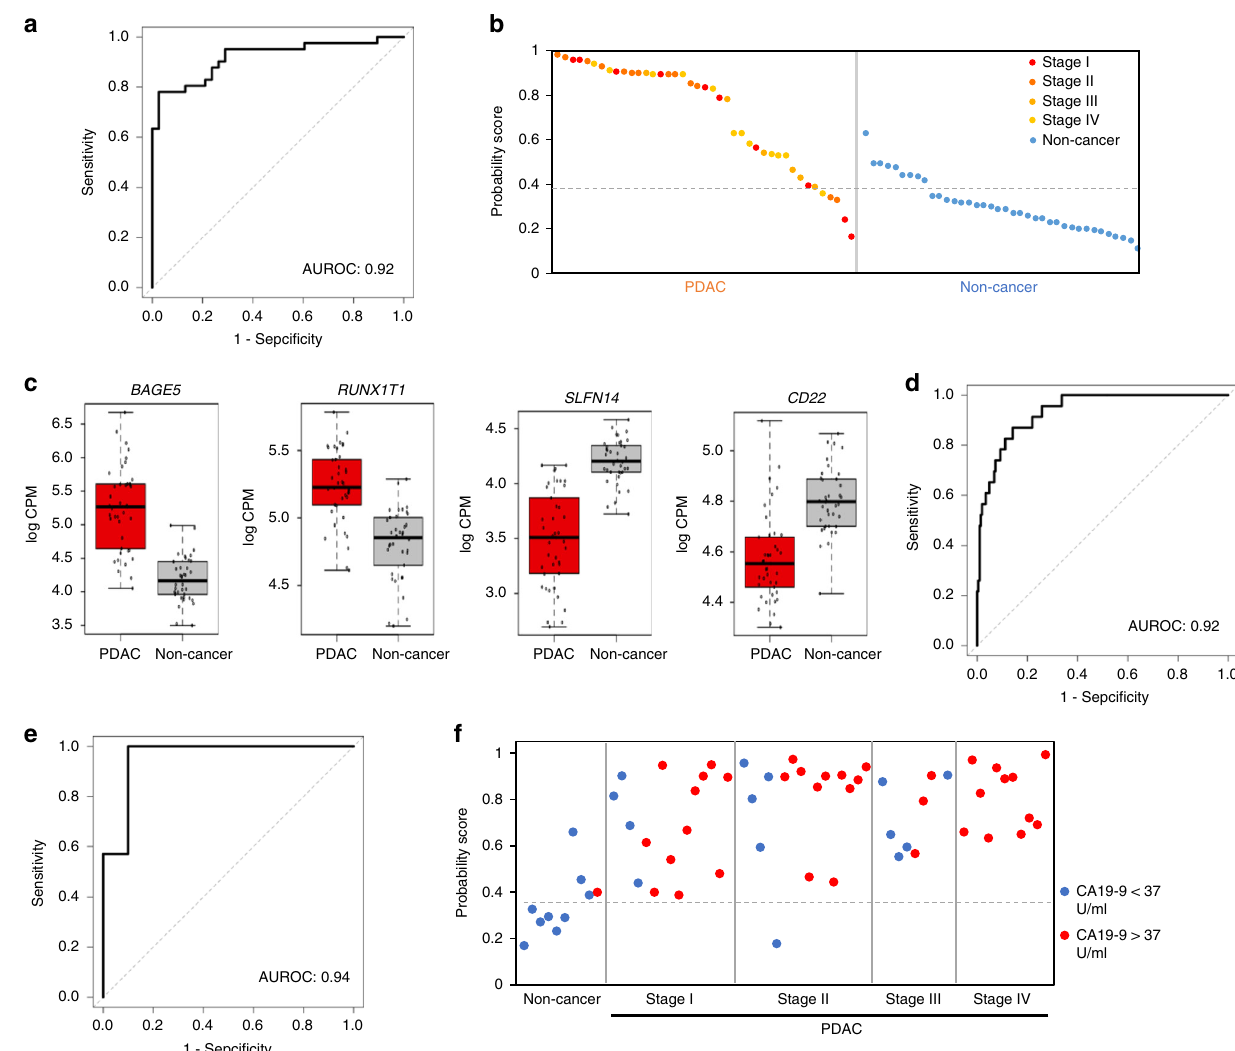
Fig. 4 Identi fi cation of a 5hmC signature that differentiates PDAC cfDNA from non-cancer samples. a Predictive modeling using regularized regression model (elastic net) on the discovery dataset with 41 PDAC and 38 non-cancer cfDNA. b Probability scores derived for each sample in the discovery dataset using the elastic net. Probability scores towards 1 are predicted cancer samples whereas probability scores close to 0 are non-cancer samples. Dotted line denotes Q3 of the probability score of non-cancer samples. c 5hmC coverage (expressed in logCPM) over BAGE5 , RUNX1T1 , SLFN14 and CD22 in PDAC ( n = 41) and non-cancer ( n = 38) cfDNA cohorts as example of top selected model features. For all boxplots, center line represents median, bounds of box represent 25th and 75th percentiles and whiskers extend to minimum or maximum values. Each dot represents an individual cfDNA sample. d , e ROC curves for independent validation cohorts of 23 PDAC cfDNA and 205 non-cancer cfDNA processed internally ( d ) and 7 PDAC cfDNA and 10 non-cancer cfDNA from Song et al. ( e ). f Predicted probability scores for non-cancer ( n = 10), and Stage I ( n = 15), Stage II ( n = 16), Stage III ( n = 8) and Stage IV ( n = 11). Same samples were also analyzed for CA19-9 levels. Samples within the clinically de fi ned normal range (0 – 37 U/ml) are denoted in blue, and samples that are above are denoted in